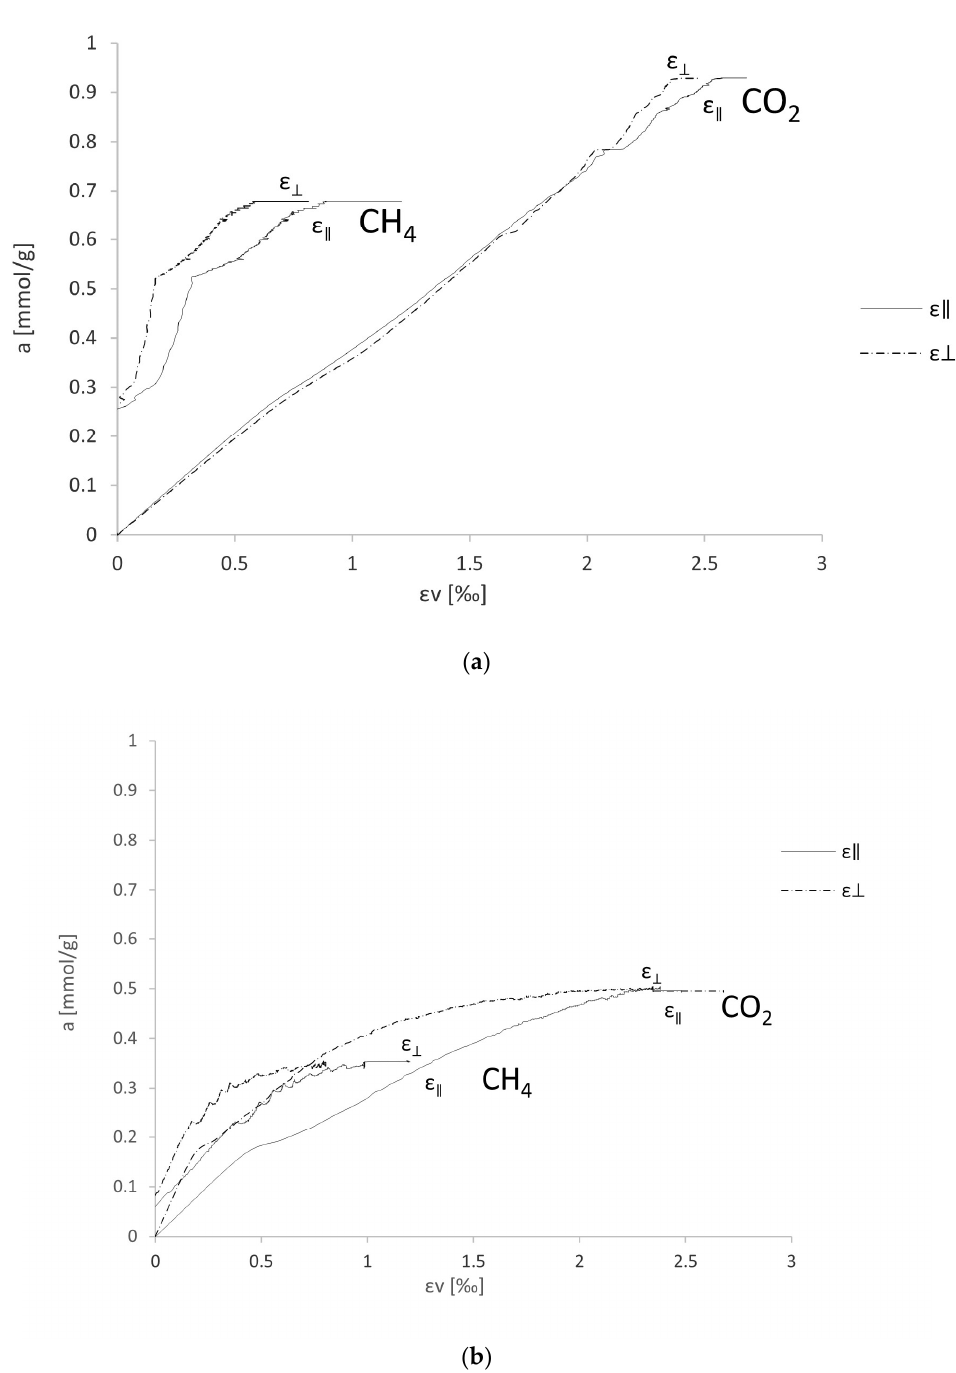
Figure 5. ( a ) Relationship between the amount of sorbed vapours and gases and the volumetric strain for sample P1. ( b ) Relationship between the amount of sorbed vapours and gases and the volumetric strain for sample P2.